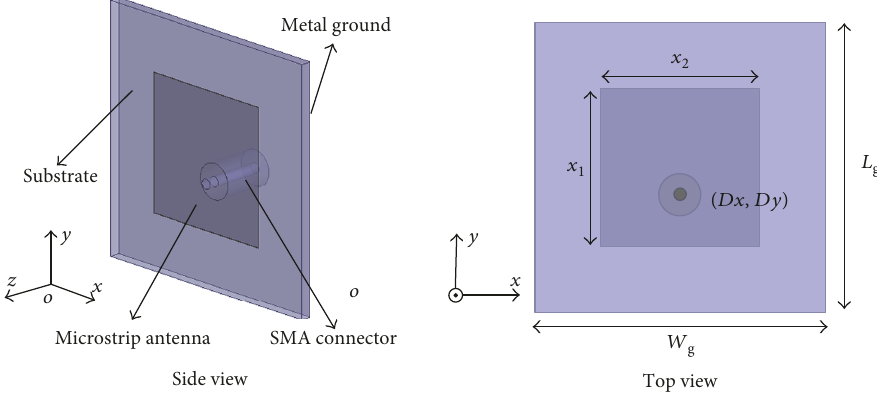
Figure 4: Geometry of microstrip antenna